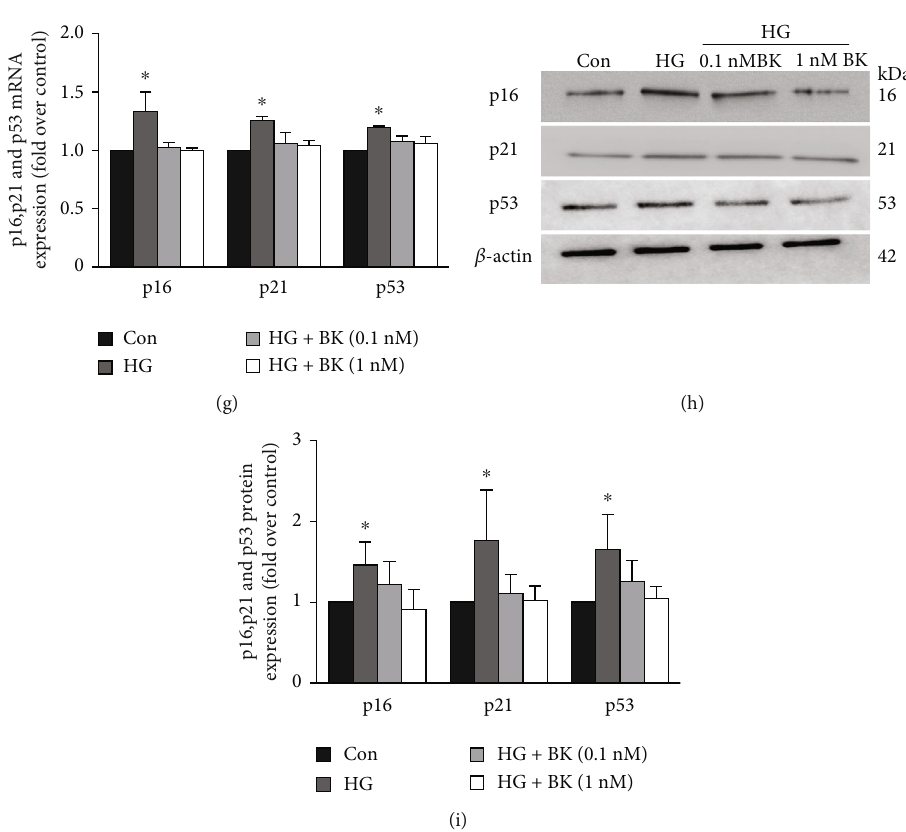
Figure 3: E ff ects of BK pretreatment on HG-induced EPC senescence. (a) Representative photomicrographs of SA- β -gal staining in EPCs. (c) Number of senescent cells after treatment. (b, d) ROS generation was analysed by Mito-Sox. (e) Cell viability was evaluated by CCK-8 assay. (f) NO production was detected by NO assay kit. (g) The mRNA expression of p16, p21, and p53 was detected by real-time PCR. (h, i) Western blotting for p16, p21, and p53 in EPCs. Bars represent the means ± SD ( ∗ P < 0 : 05 versus control; n = 6